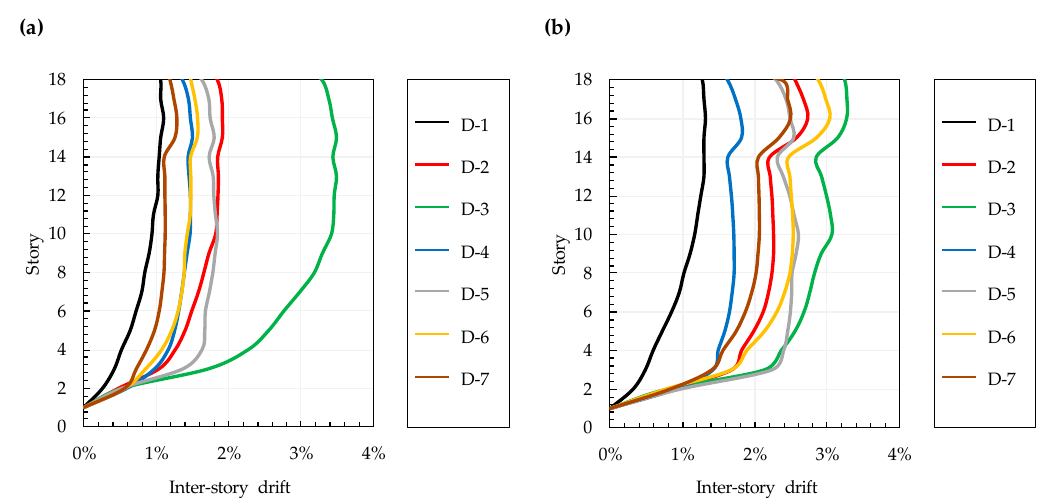
Table 4. Results from the dynamic wind analysis.